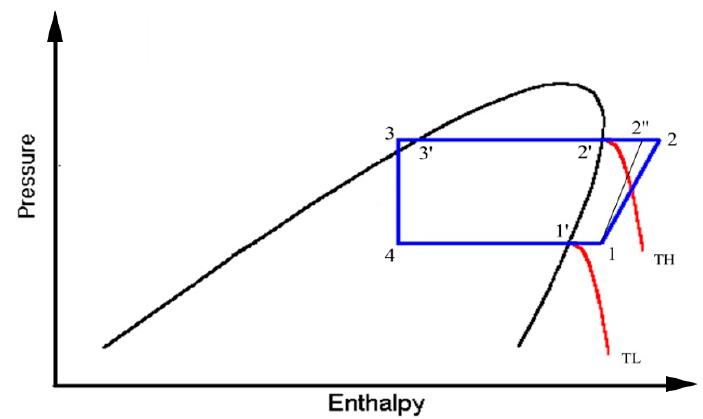
Figure 2. Refrigeration cycle represented on the enthalpy ‐ pressure plan (p ‐ H).